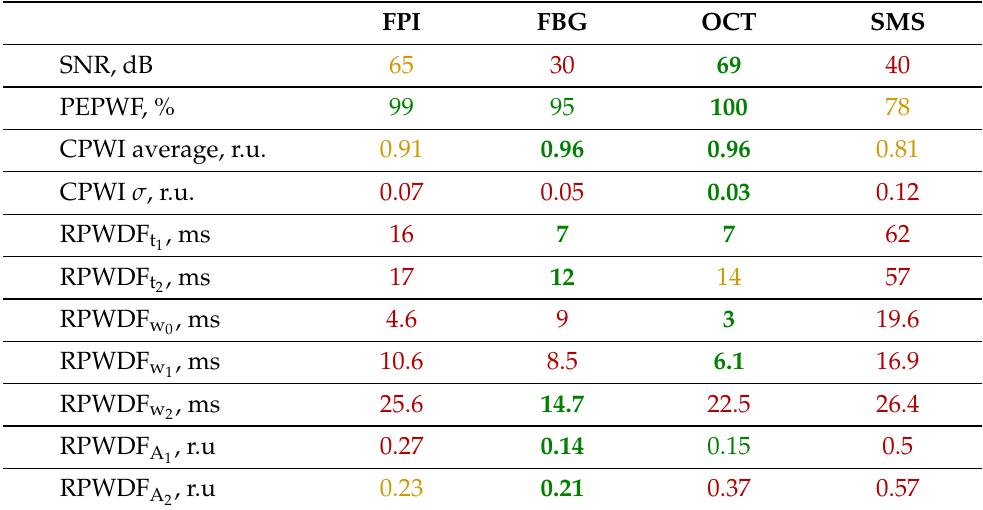
Table 1. Comparison of pulse wave signals measured with different sensors. Best scores are shown in bold. Green text color shows the values that deviate not greater than 5% from the best score, orange text color—values which deviation from the best score is between 5% and 25%, red text color—values which deviation from the best score is greater than 25%. FPI FBG OCT